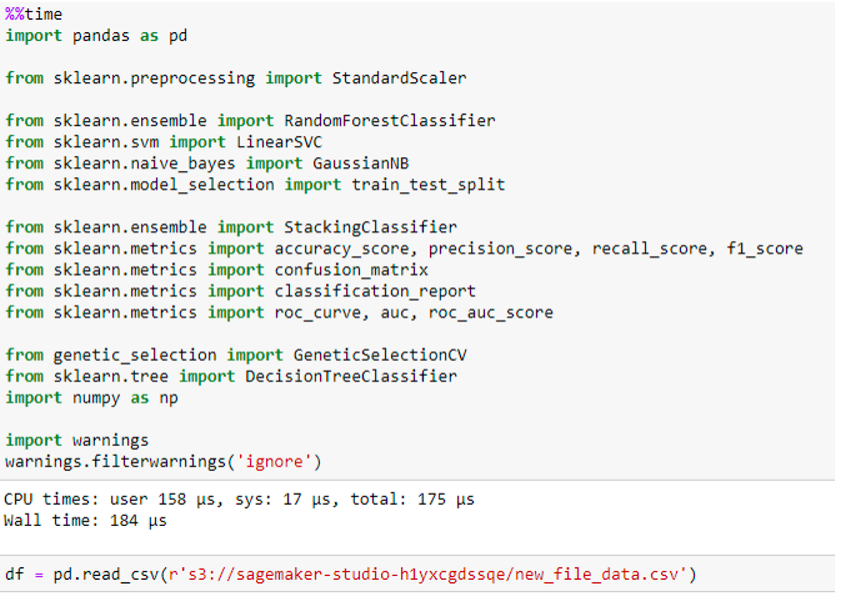
Figure 13. Genetic Algorithm Implementation Improving